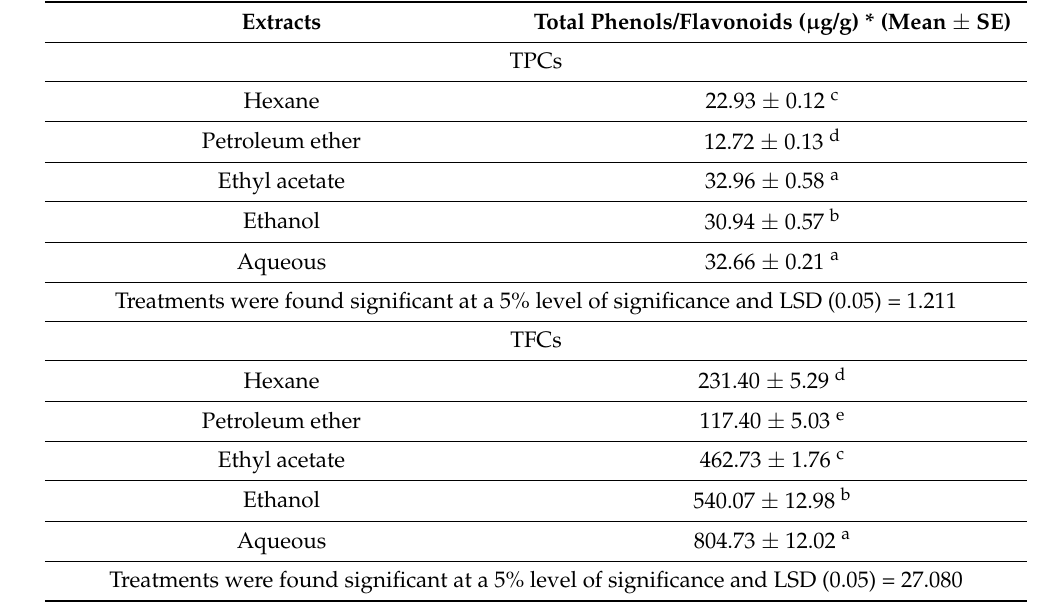
Table 3. The total amount of phenolic and flavonoid compounds of different successive extracts of